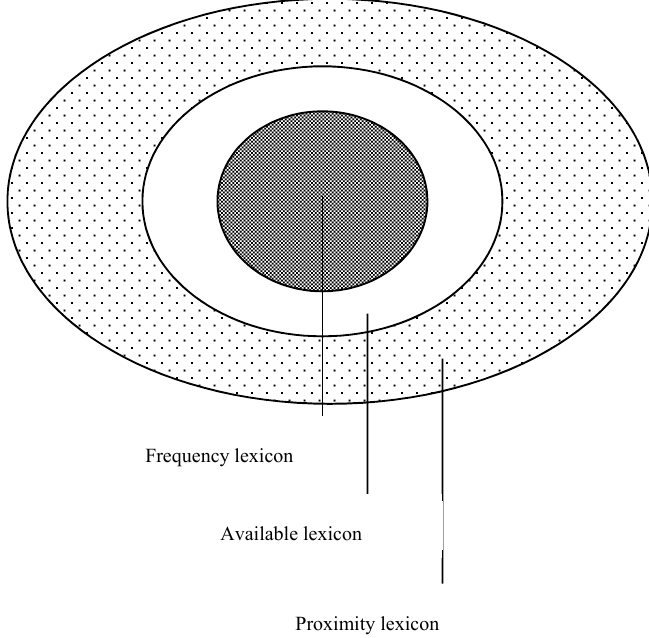
Figure 1. Representation of the general lexical selection model based on the concentrical crowns. (Ávila-Muñoz 2017).